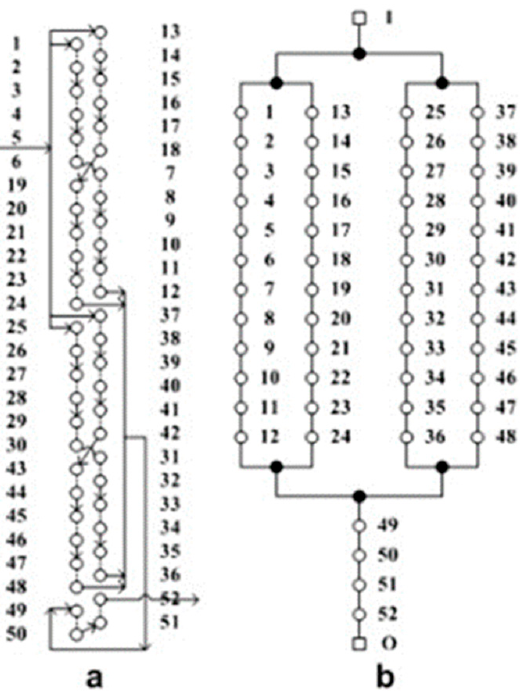
Figure 20. Circuitry layout ( a ) and connection map ( b ) for simulated condenser [94].